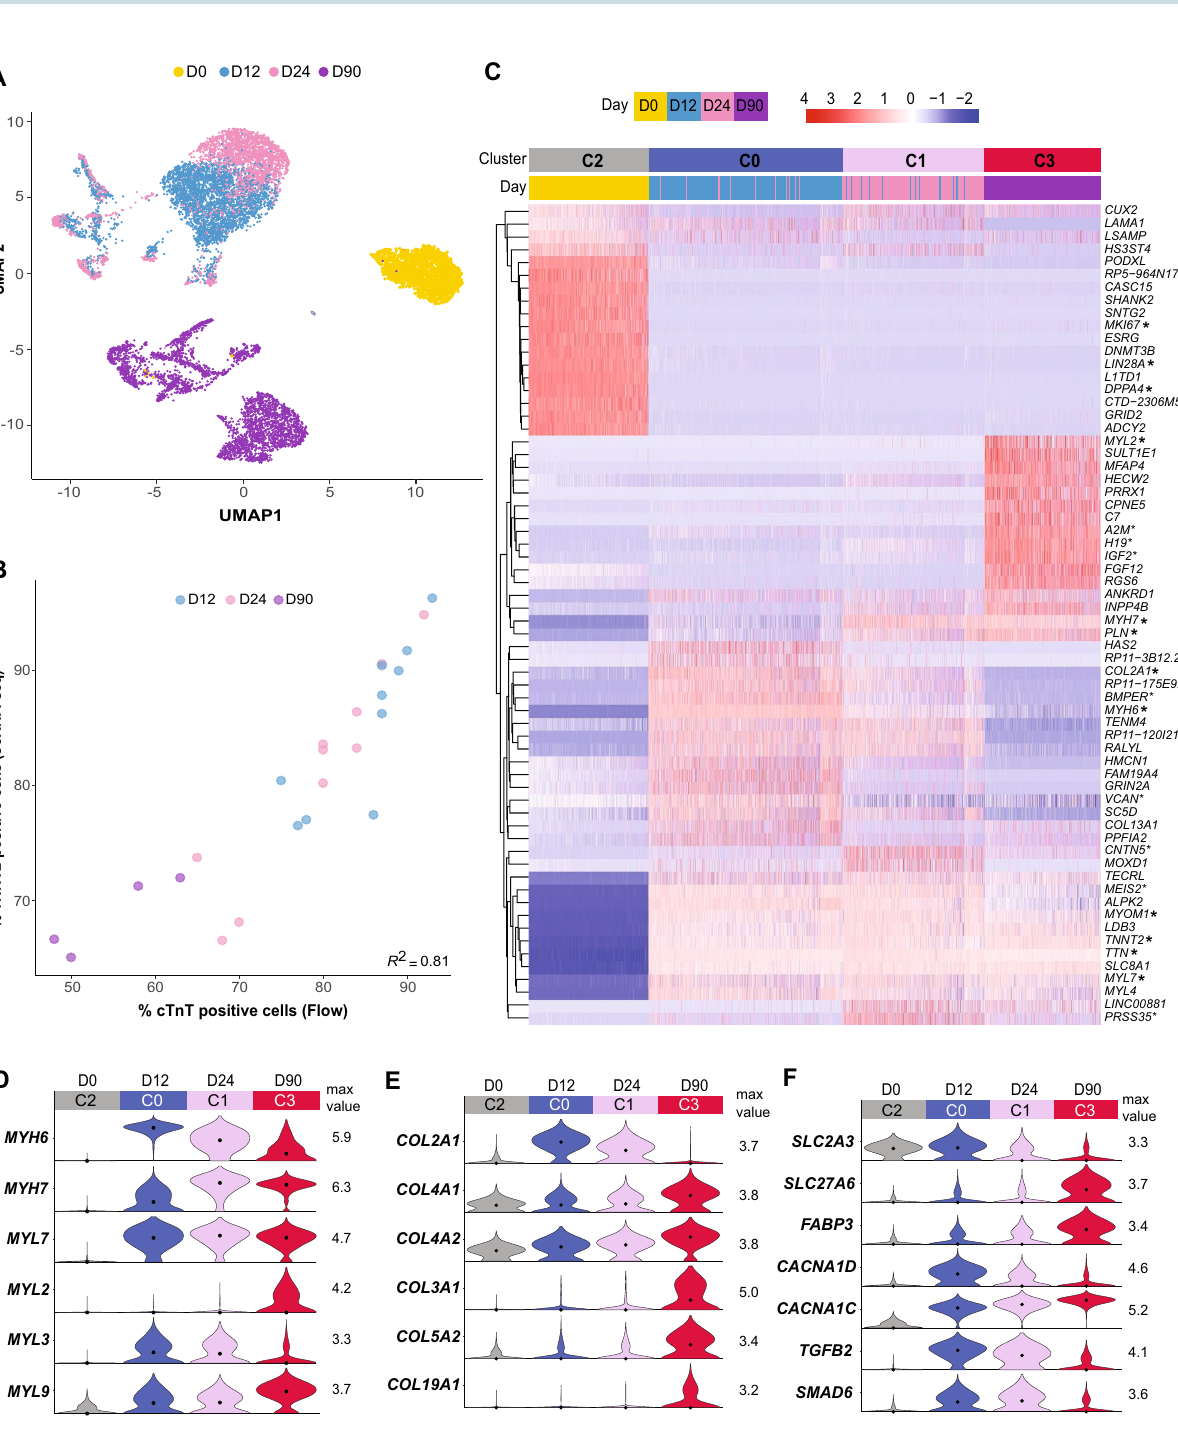
Figure 2. Transcriptional shifts between differentiation time points reveal changes in cardiomyocytes over time in culture. ( A ) Same UMAP as shown in Fig. 1B, colored by collection time point; yellow—D0 undifferentiated hiPSCs; blue- D12 cells, pink- D24 cells, purple- D90 cells. ( B ) Pearson correlation of cells expressing TNNT2 by scRNA-seq and flow cytometry. The percent of TNNT2 + cells in each sample from the scRNA-seq data is shown relative to the percent of cardiac troponin T (cTnT)+ cells from each sample determined by flow cytometry. Individual points are colored according to time point; R 2 = 0.81, p = 1.73e −09 . ( C ) Differentially expressed genes were identified between pairs of clusters corresponding to the undifferentiated hiPSC population (C2) and the three largest cardiomyocyte populations: D12 (C0), D24 (C1), and D90 (C3). Heatmap shows the top 10 up- and down-regulated genes from each pairwise cluster comparison. Normalized transcript abundance was centered and scaled across each row (z-score color scale on top; red = standard deviations above mean; blue = standard deviations below mean; white = mean; for visualization purposes, 4 was set as the maximum z-score, and z-scores > 4 were set to 4). The dendrogram is based on hierarchical clustering of genes. Each column corresponds to one cell. Genes referenced in Results are noted with an asterisk. ( D ) Transcript abundance distributions for genes encoding myosin heavy and light chains with temporal transcriptional shifts between D0 (C2), D12 (C0) cardiomyocytes, D24 (C1) cardiomyocytes, and D90 (C3) cardiomyocytes. Max value = maximum value of log1p normalized counts; dot = median. ( E ) Same as D but showing genes encoding collagens. ( F ) Same as D and E , but showing genes encoding molecular transporters, ion channels, and signaling